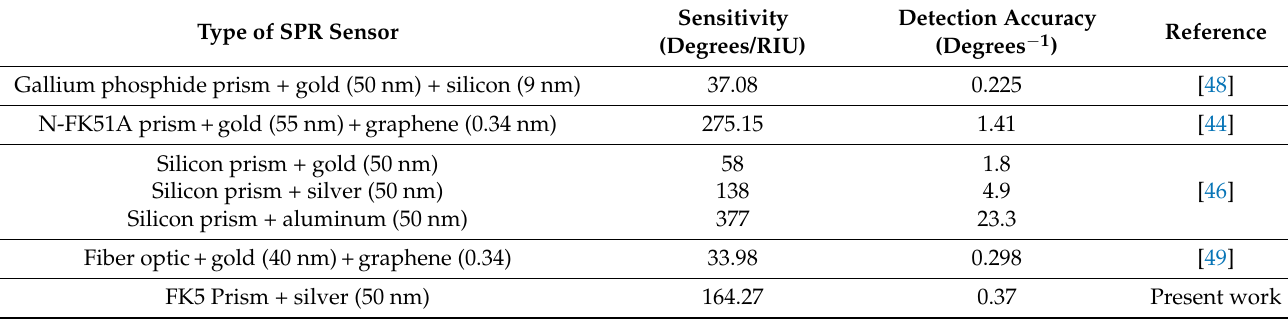
Table 4. Comparison of sensing performance of SPR